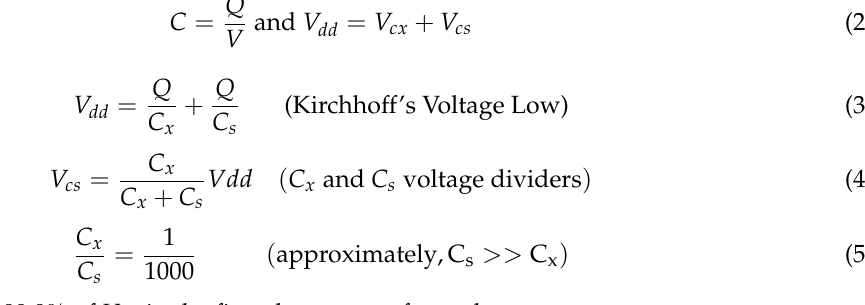
Figure 2. ( a ) The equivalent circuit in measurement phase [17]; ( b ) field coupling between electrodes.